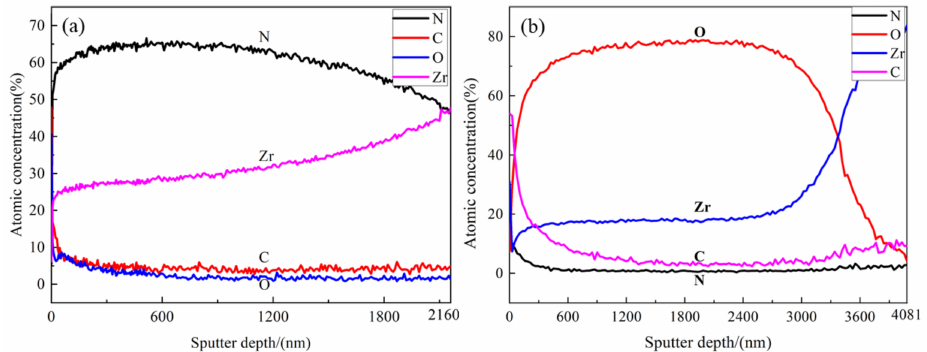
Figure 5. AES element distribution in the film with sputtering depth: ( a ) nitride film prepared in this paper; ( b ) oxide film prepared by Yan et al. [21].